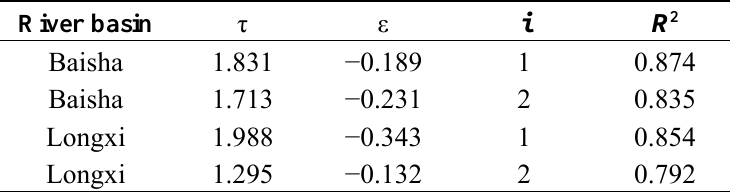
Table 3. Parameters of Equation (3) in river